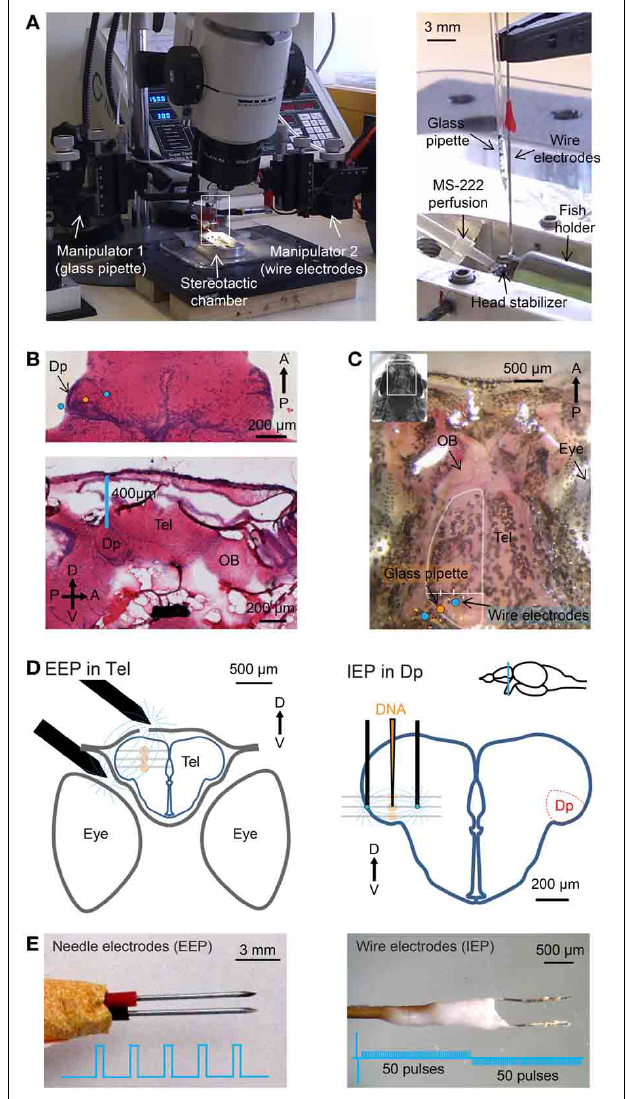
FIGURE 1 | Stereotactic injection and electroporation. (A) Left: apparatus for injection and electroporation. Right: Arrangement of wire electrodes and glass micropipette for targeted electroporation with internal electrodes (IEP) in the stereotactic chamber. Positions of electrodes and micropipette relative to Dp are shown schematically in (D) . (B) Top: hematoxylin and eosin (H&E) staining of a horizontal brain section through Dp. Somata are stained blue. Approximate positions of injection pipette and wire electrodes for targeted IEP in Dp are indicated. Bottom: sagittal section. D, dorsal; V, ventral; A, anterior; P, posterior. (C) Dorsal view of the skull over the telencephalon (Tel) and olfactory bulb (OB). The bone over the left olfactory bulb has been removed. Positions of the glass pipette and wire electrodes for targeted IEP in Dp are indicated. A virtual line between the lateral edge of the telencephalon and the midline (white) was used to determine the position of the injection pipette along the medial-lateral axis (Methods). (D) Approximate positions of electrodes (black) and injection sites (orange) for EEP in the dorsal telencephalon (left) and targeted IEP in Dp (right). Plasmid was injected and electroporated sequentially at three different depths (gray lines). (E) Needle electrodes for “external-electrode-electroporation” (EEP; left) and wire electrodes for “internal-electrode-electroporation” (IEP; right). Insets show electrical pulse